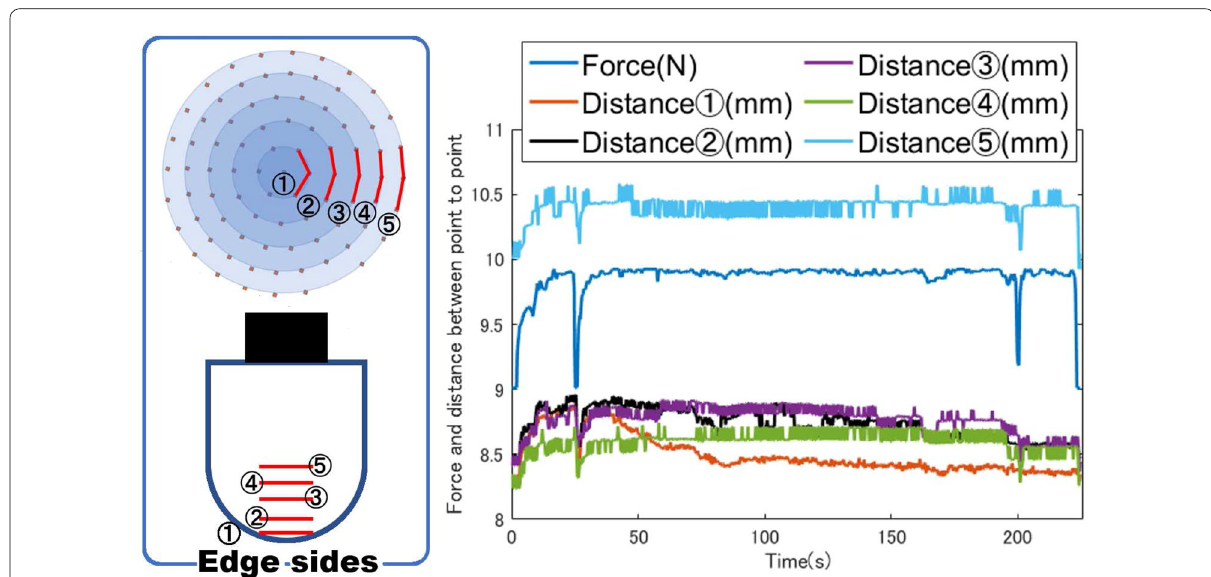
Fig. 12 Change in distance between the point markers on both upper edge sides according to the contact position after correcting the non‑linearity: the relationship between the contact position and the change in distance between the point markers is almost linear, especially in area 4 and area